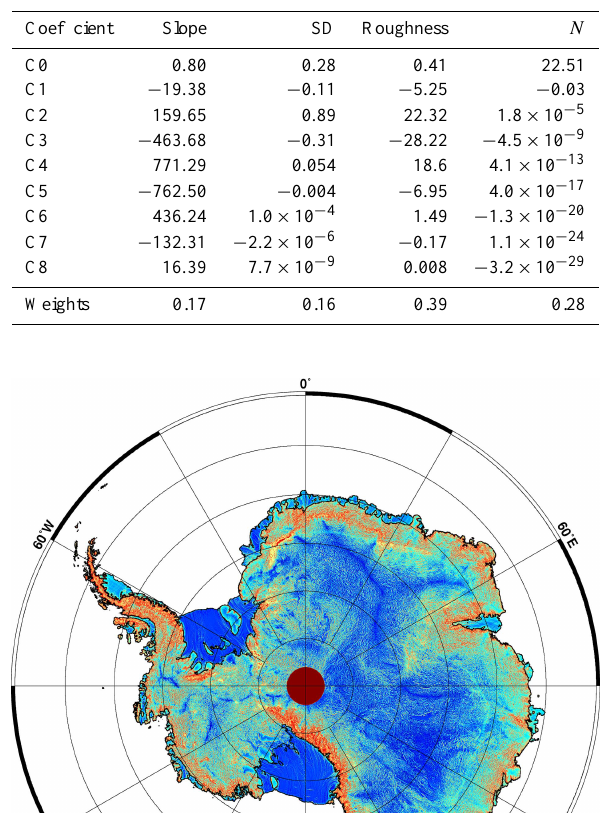
Table A2. Polynomial fit coefficients and weights used for the Antarctica uncertainty grid.